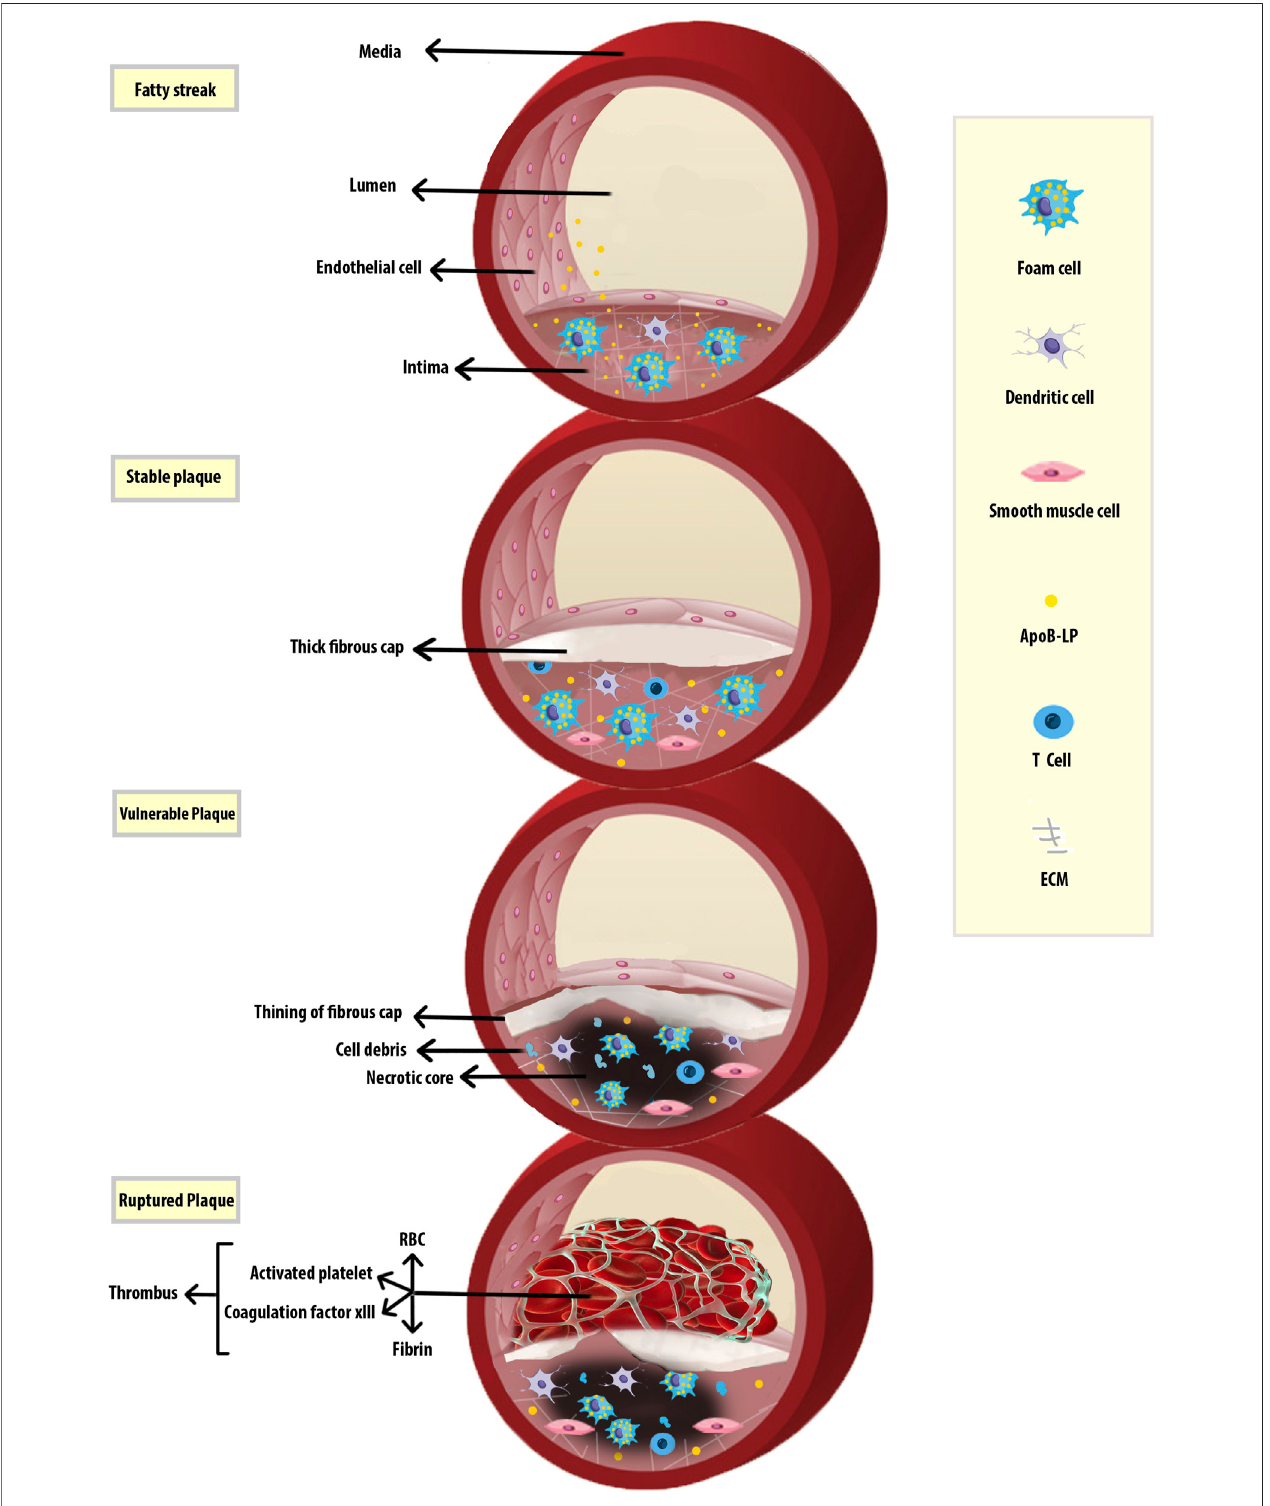
FIGURE 1 | Progression of Atherosclerosis. Early fatty streak lesions are characterized by subendothelial accumulation of ApoB-LPs, the main protein constituent of lipoproteins such as VLDL and LDL which promote the recruitment of M φ s. As the atherosclerotic lesion progresses, ApoB-LP retention is ampli fi ed. Vulnerable plaquesarecharacterizedbytheaccumulation ofACsanddefectiveefferocytosis, resultinginthelipid- fi llednecroticcore.Athinning fi brouscapreduces plaquestability and makes them susceptible to rupture and thrombus formation. Apolipoprotein B-containing lipoproteins (ApoB-LPs).